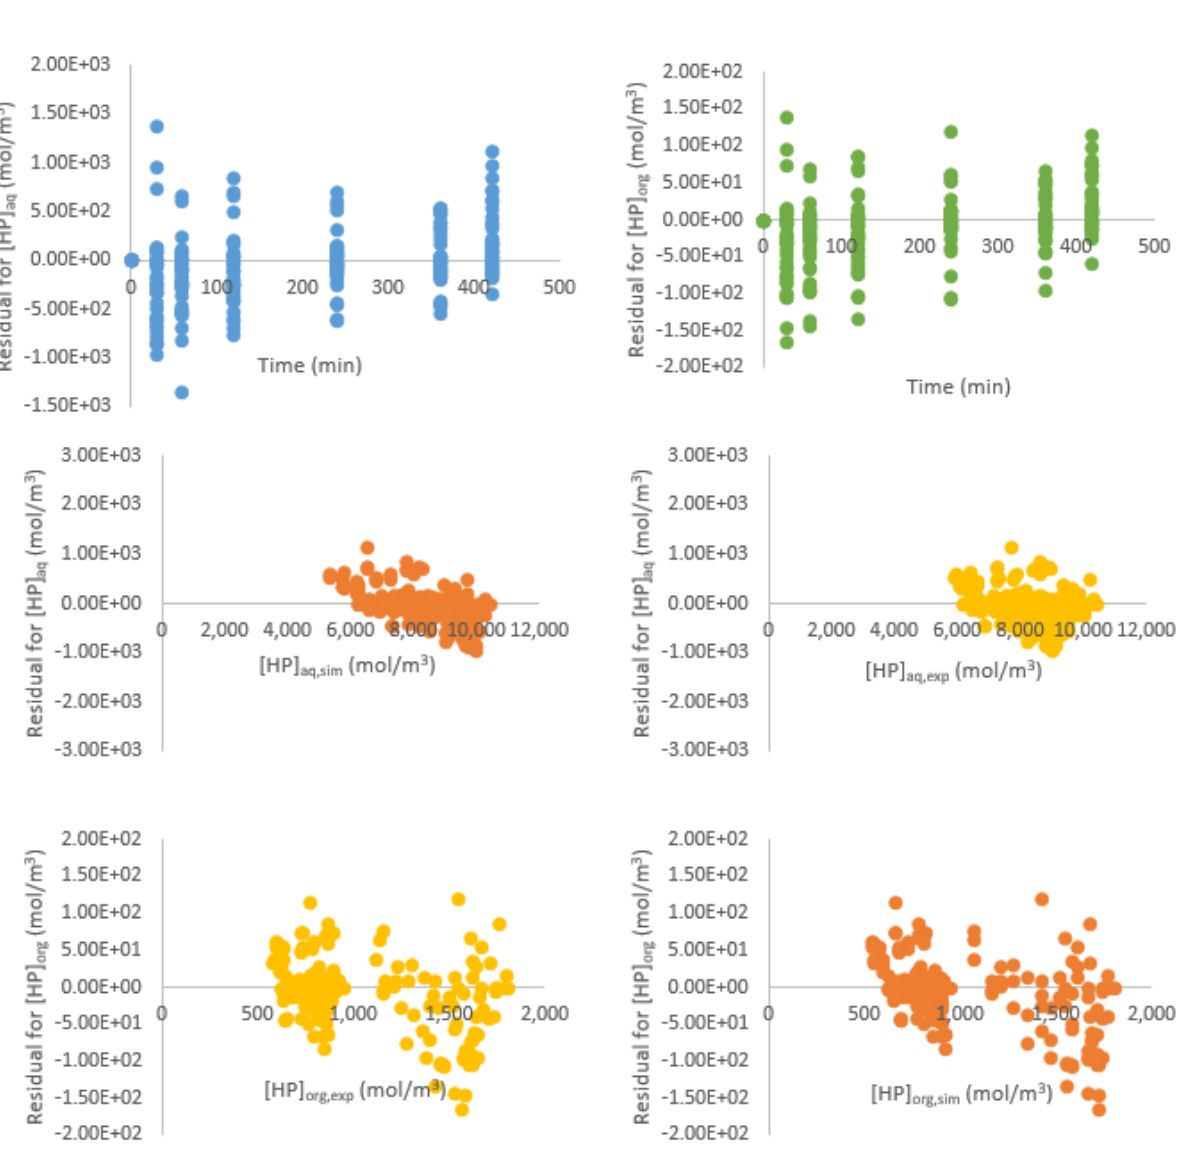
Figure A1. Distribution of residuals for Model d.